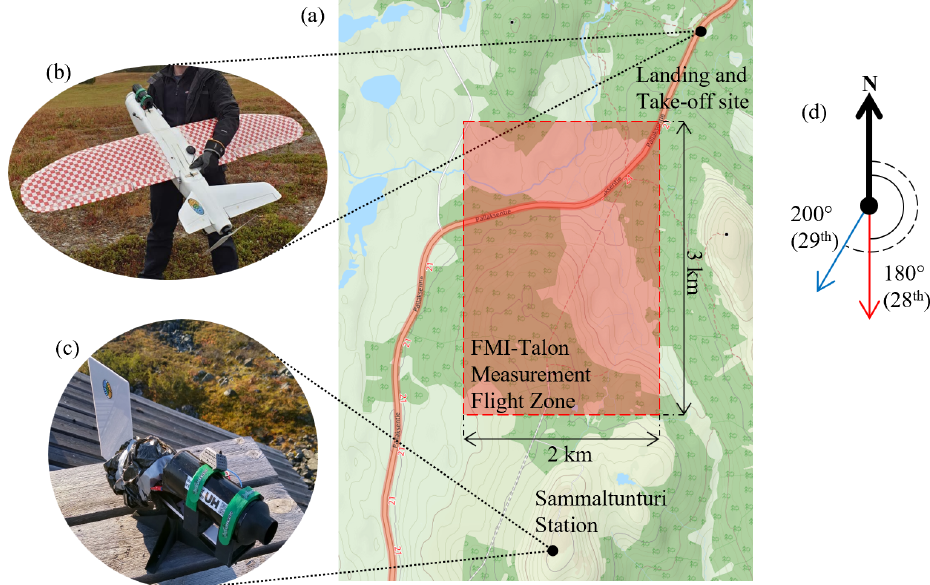
Figure 7. A series of illustrations designed to give context to the measurement campaign. Figure 7a shows a map of the area including Sammaltunturi station – obtained from ©OpenStreetMap contributors 2017. Distributed under the Open Data Commons Open Database License (ODbL) v1.0., the UAV landing site, and the flight operations zone in the red square; panel (b) shows the UCASS mounted to the FMI-Talon; panel (c) is an image of the UCASS – wind-vane system mounted to the station; and panel (d) shows the wind directions, measured by Sammaltunturi station, on 28 and 29 September with red and blue arrows, respectively.